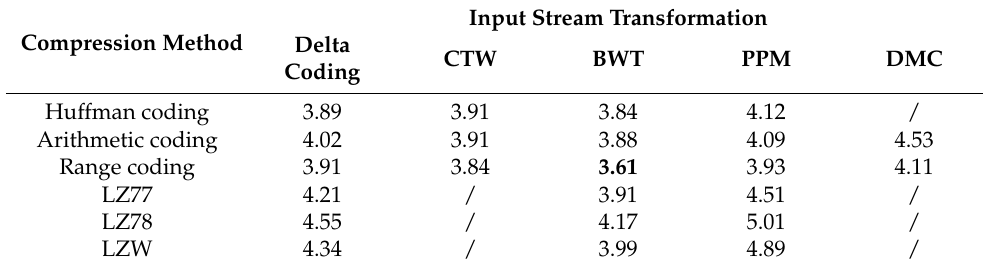
Table 6. AAE for all possible combinations of the compression and transformation. Compression